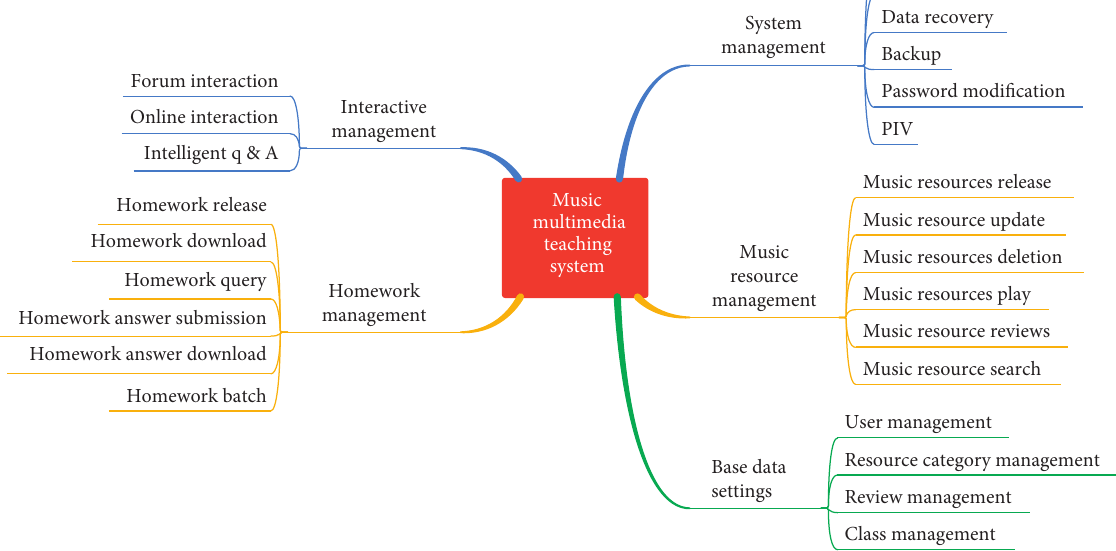
Figure 4: Functional structure diagram.